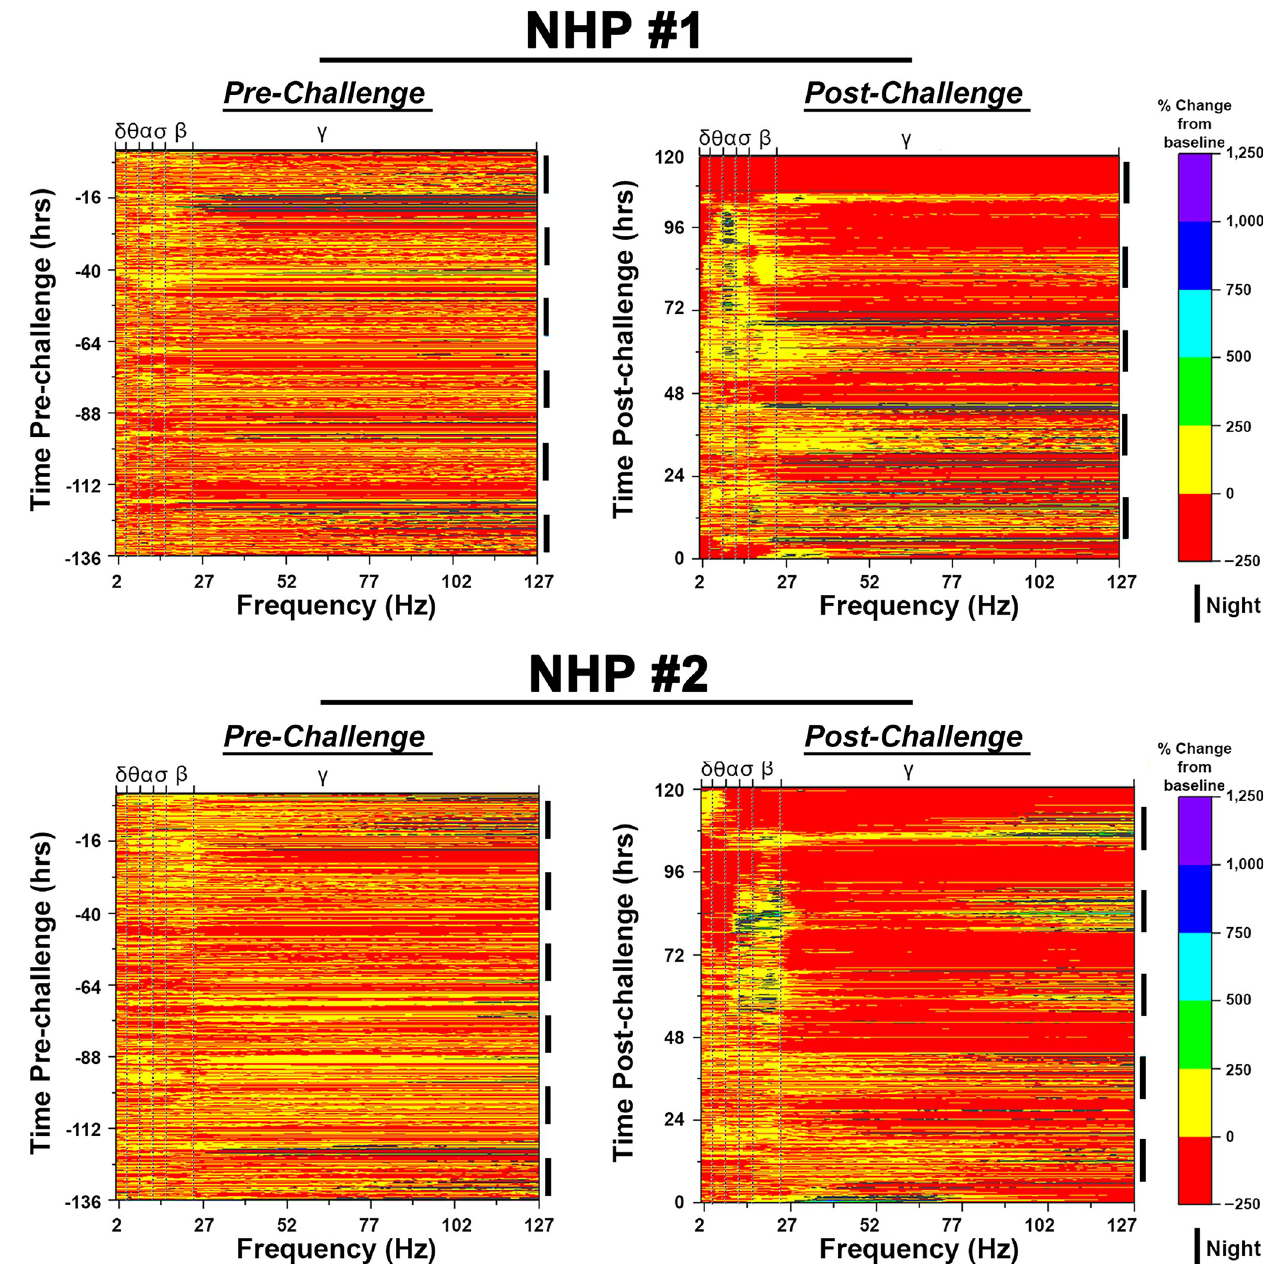
Fig 11. Pre- and post-EEEV challenge quantitative electroencephalography (qEEG) heat maps of NHPs #1 and #2. The top and bottom x-axes display brain waves [(delta ( δ ), theta ( θ ), alpha ( α ), sigma ( σ ), and gamma ( γ )] and frequency in hertz (Hz), respectively. The left and right y-axes display time (hr) and 12-hr day/night time intervals, respectively. 12-hr nighttime is indicated by ( ▐ ) and daytime by a gap. Pre-EEEV challenge baseline (left) and post-EEEV challenge (right) heat maps are